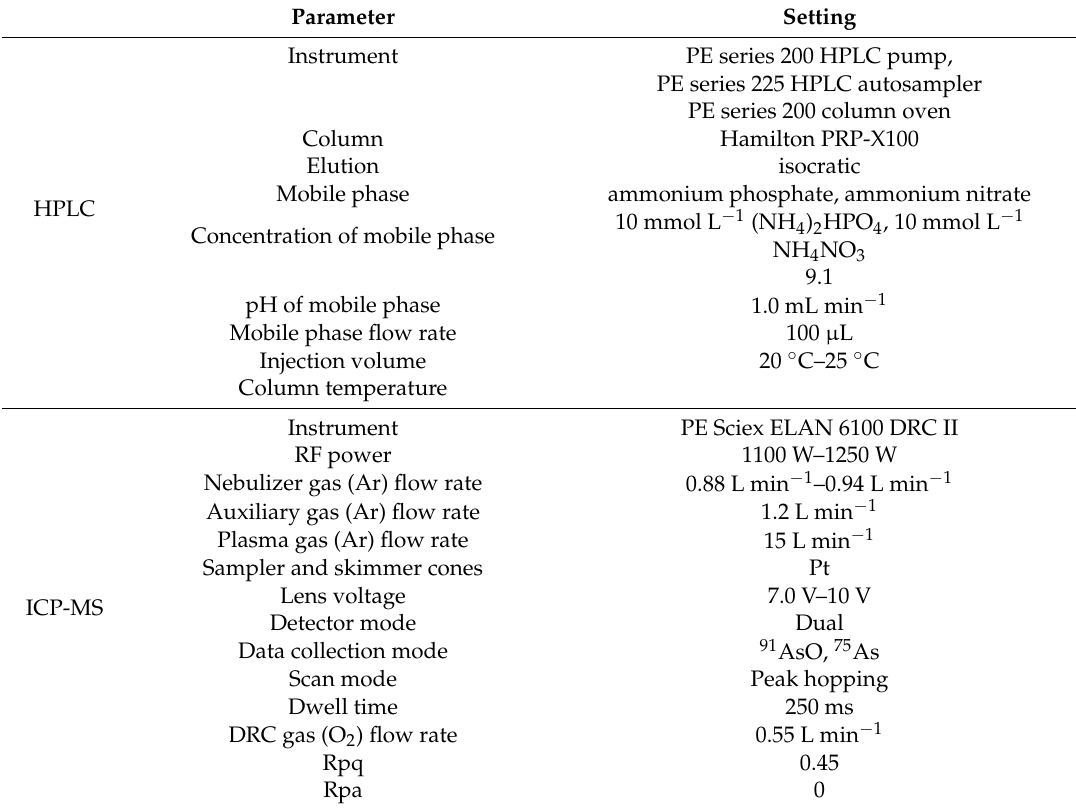
Table 6. Optimization parameters for separation and determination of TAs and AsB, As(III),